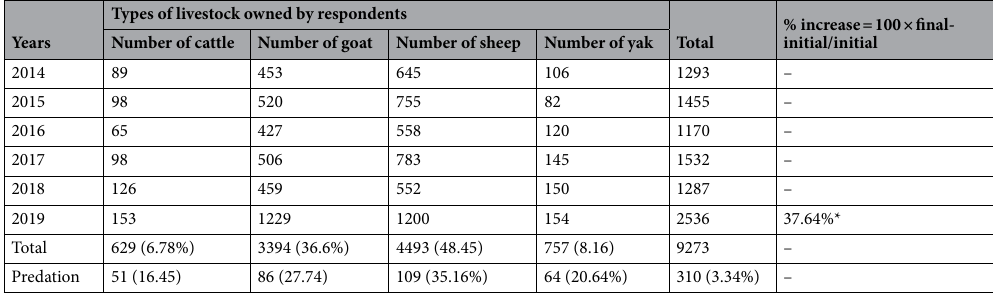
Table 2. Livestock holding in Misgar valley, district Hunza, during years 2014–2019. *Percent increase after 4 years’